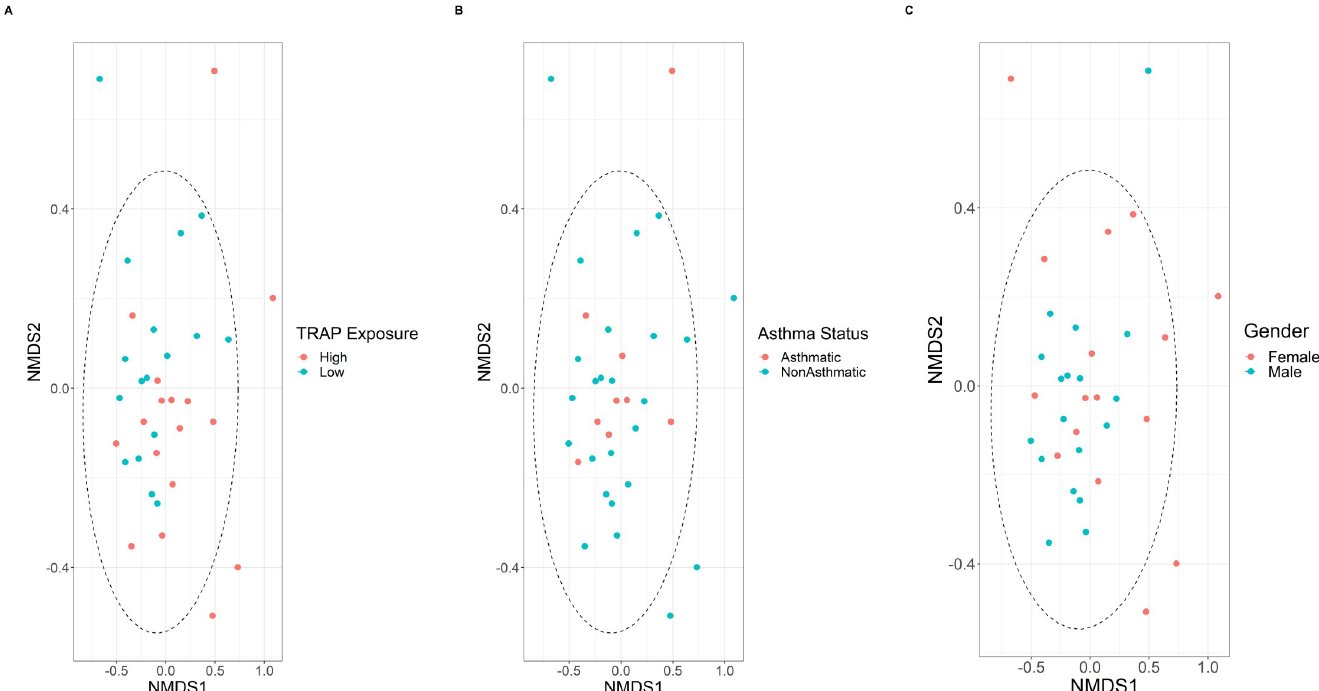
Fig 4. Non-metric multidimensional scaling (NMDS) of Bray-Curtis distances of bacteria in sputum microbiota from each TRAP exposure group, asthma status group, and gender.